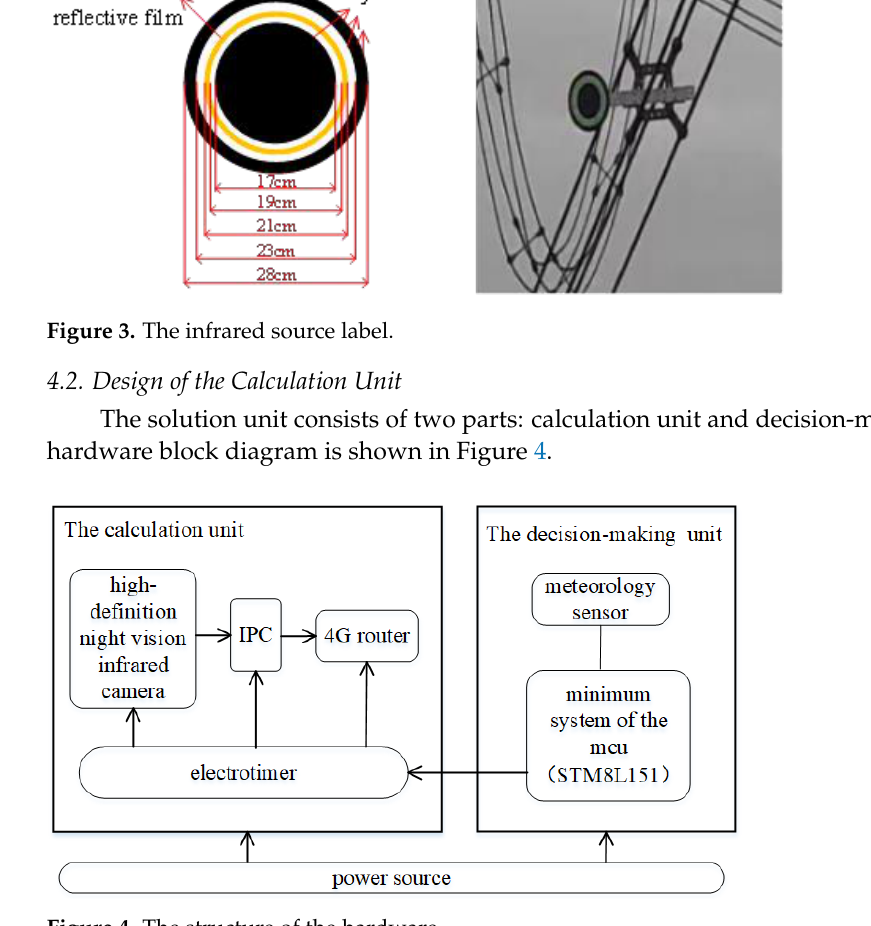
Figure 3. The infrared source label.